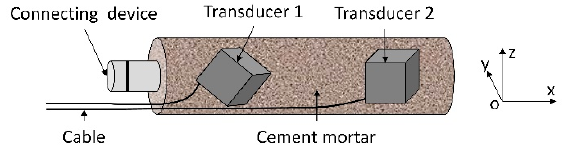
Figure 2. Schematic diagram of the grouted sensing column showing the placing of the two transducers.